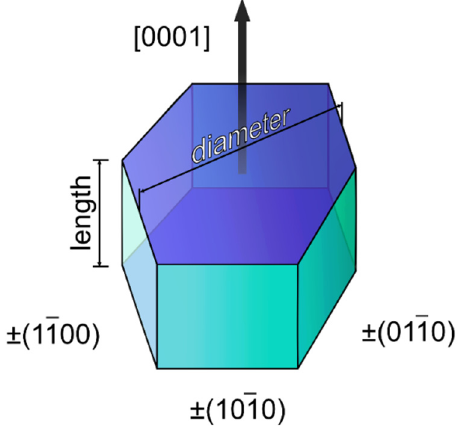
Figure 6. The shape and the anisotropy of the hexagonal prisms of β -NaYF 4 .